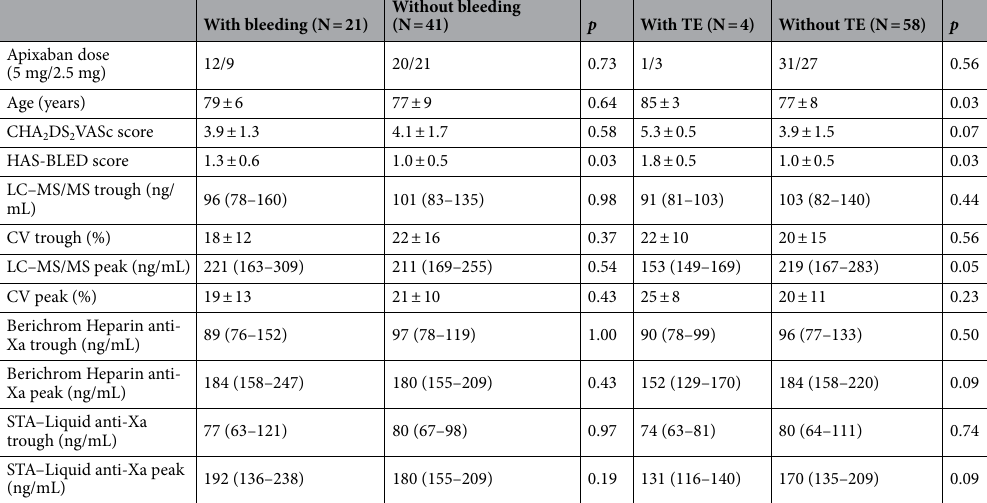
Table 3. Characteristics of patients with bleeding or thromboembolic event (TE) and patients without. Results are shown as number of cases, average ± SD or median with first to third quartile. CV oefficient of variation.